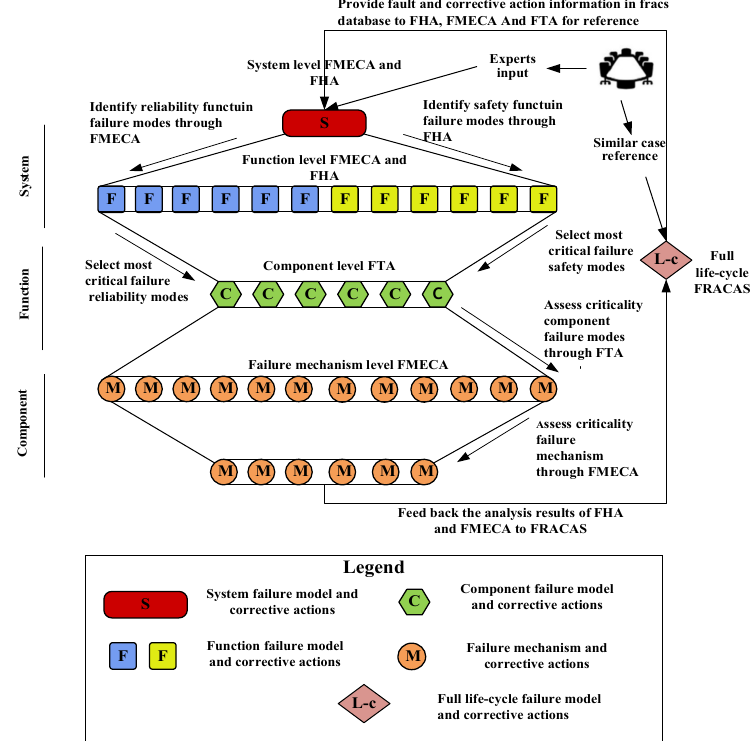
Figure 7. The 4F integration technology analysis process.